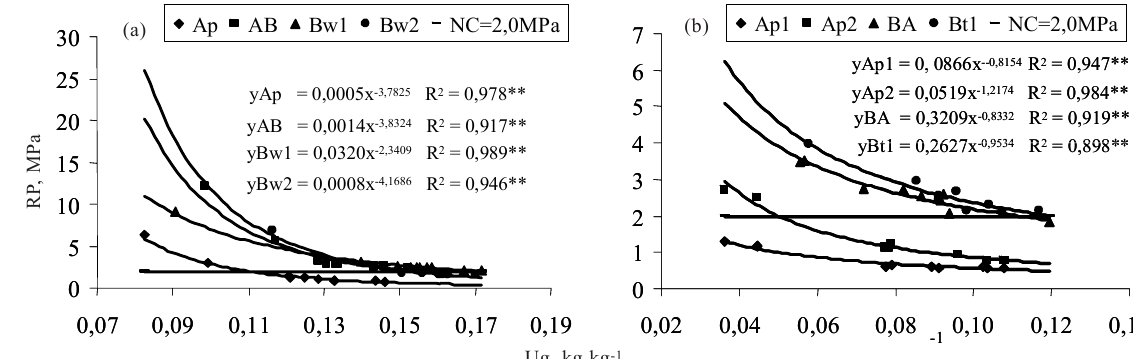
Figura 7. Relação entre densidade de raízes de citros e condutividade hidráulica saturada (K Latossolo Amarelo (a) e Argissolo Acinzentado (b) de Tabuleiros Costeiros da Bahia, na avaliação de indicadores de horizontes coesos.